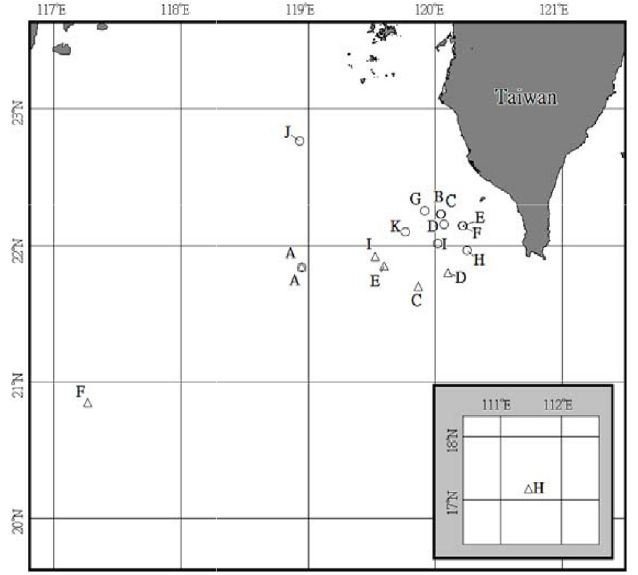
Fig. 2. Deployment and pop-up positions of 11 yellow fi n tuna (labeled from A to K) tagged with satellite archival tags in the waters off southwestern Taiwan from 2011 to 2013. ○ : Deployment locations, △ : pop-up endpoint positions.